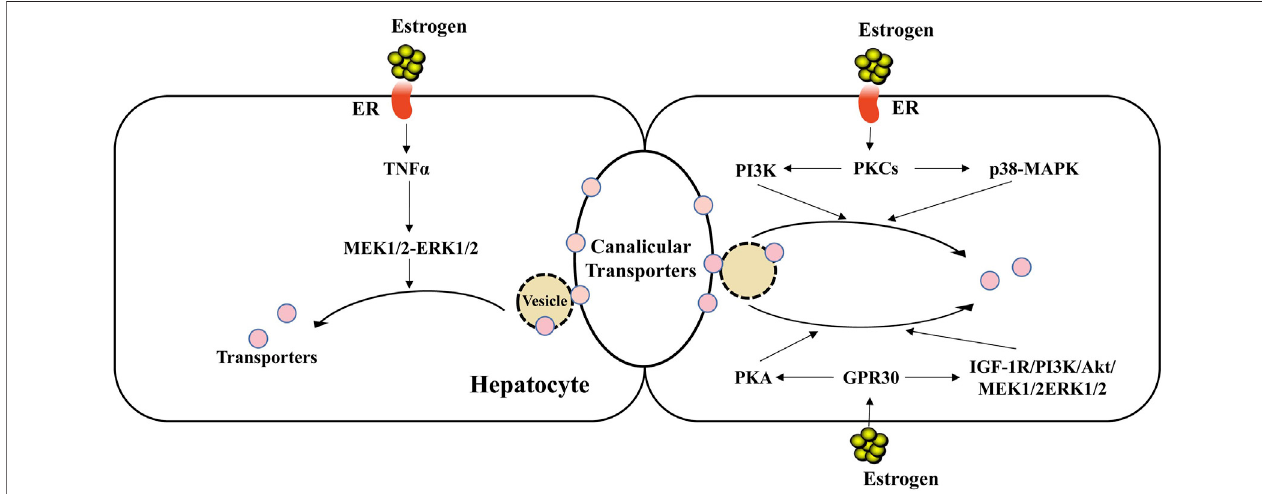
FIGURE 2 | Endocytic internalization of canalicular transporters in EIC. Estrogen can induce the endocytic internalization of canalicular transporters through intracellular signaling cascades, such as PKCs-PI3K/p38 MAPK, GPR30-PKA/TGF1R-PI3K-Akt-MEK1/2-ERK1/2, leading to decreased expression of canalicular transportersanddecreasedbile fl ow.Besides,theincreasedlevelofhepaticTNF α inEICmayparticipateintheinternalizationoftransportersbytheactivationofMEK1/2- ERK1/2 signaling